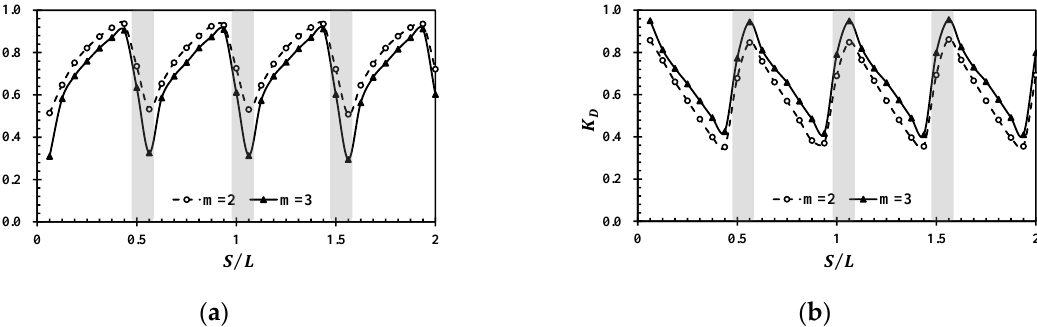
Figure 11. Comparison of the reflection and the dissipation coefficients for the different structure configurations with kd = 0.6. ( a ) m = 2. ( b ) m = 3.